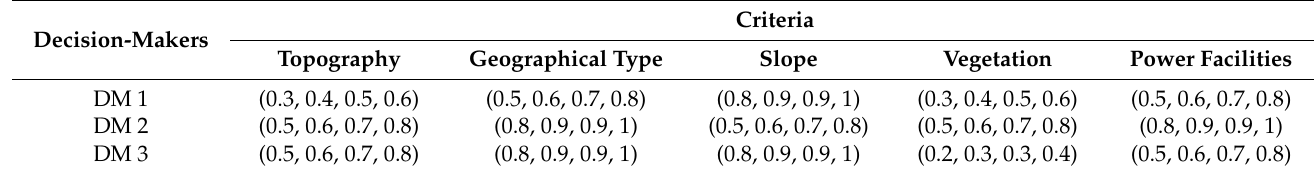
Table 9. Fuzzy values of linguistic terms of criteria.